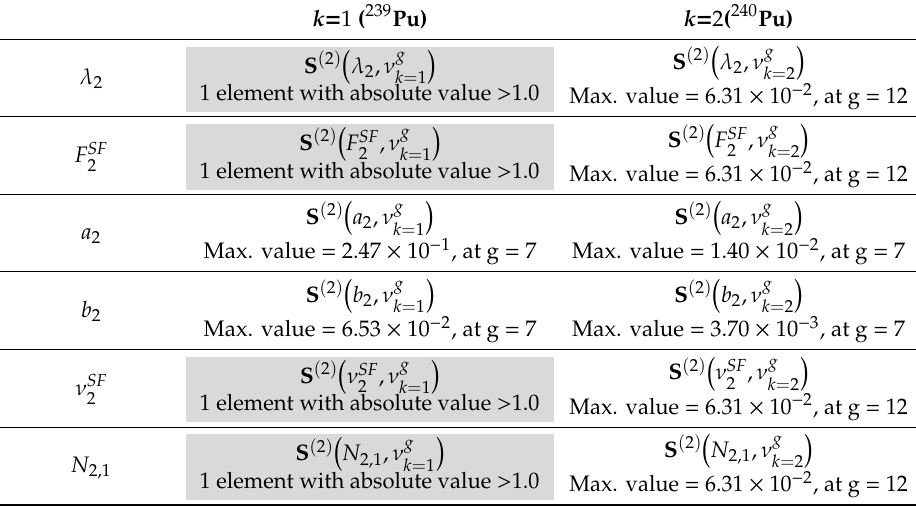
Table 13. Summary results for S ( 2 ) relative sensitivities of the leakage response with respect to the source parameters of isotope 240 Pu and the average number of neutrons per fission for all fissionable